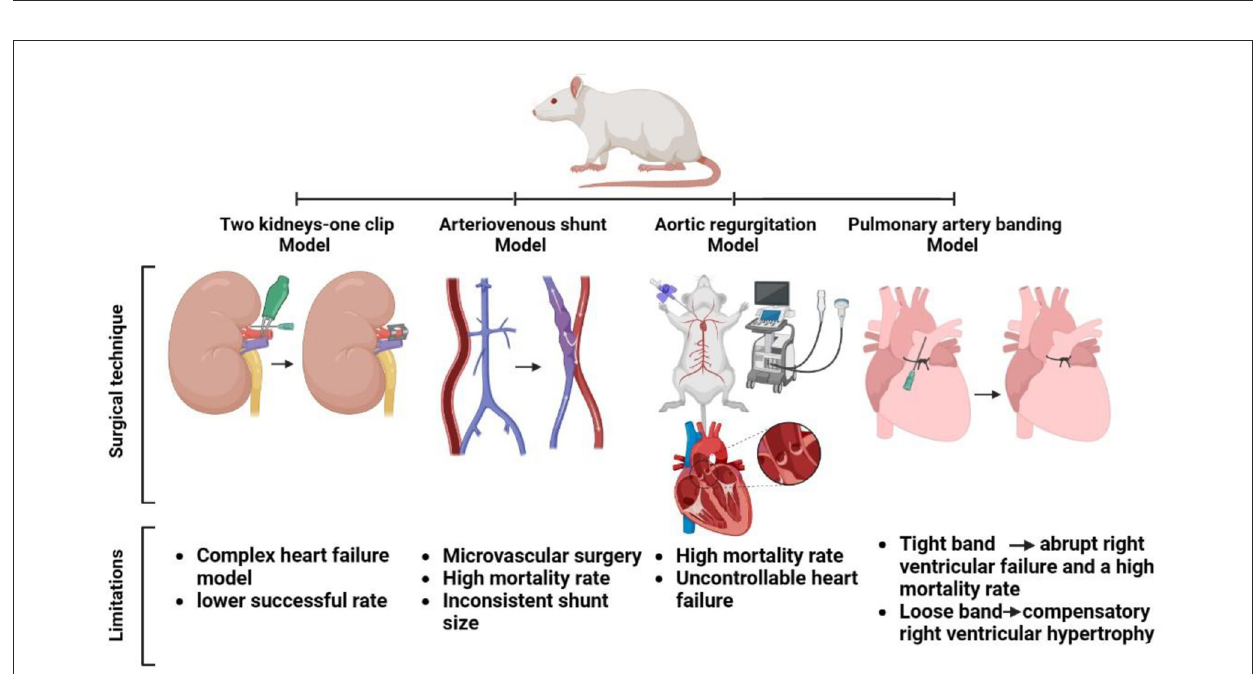
FIGURE3 Surgical approach and shortcomings in some heart failure models in rats (two kidneys-one clip, arteriovenous shunt, aortic regurgitation, and pulmonary artery banding